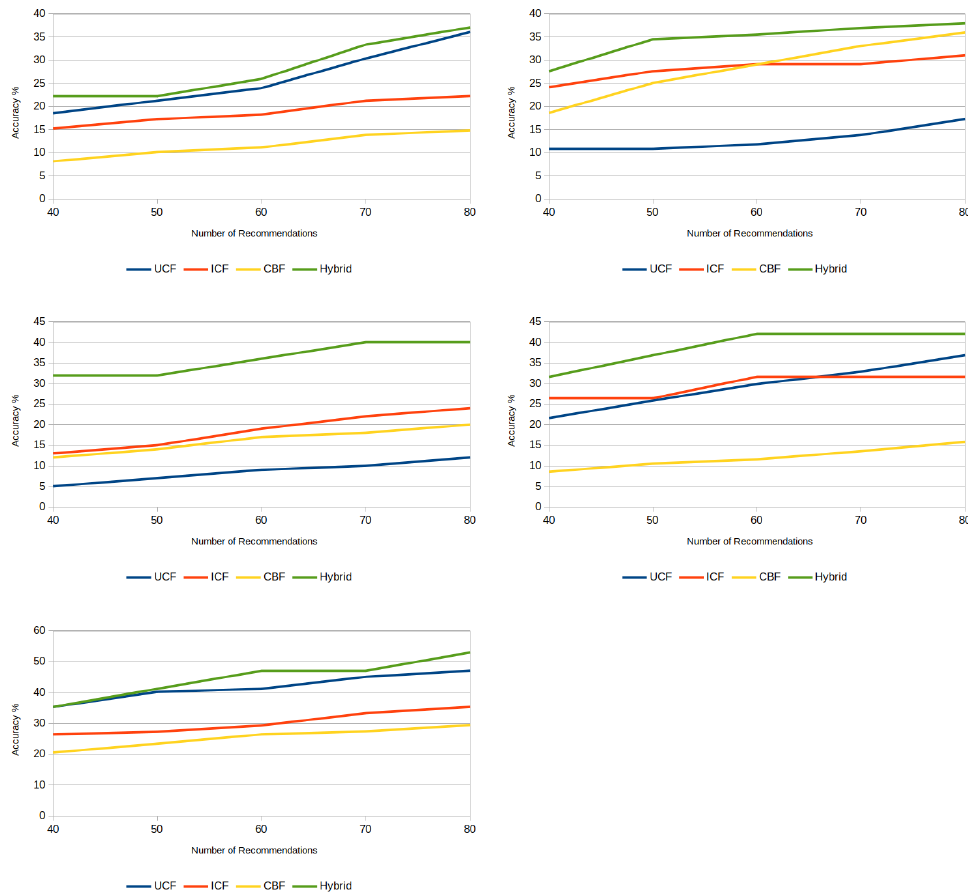
Figure 6. Performance comparison of hybrid recommendation technique over other techniques for five different users. The blue, red, yellow, and green lines show performance score of the recommendation techniques UCF, ICF, CBF, and hybrid,